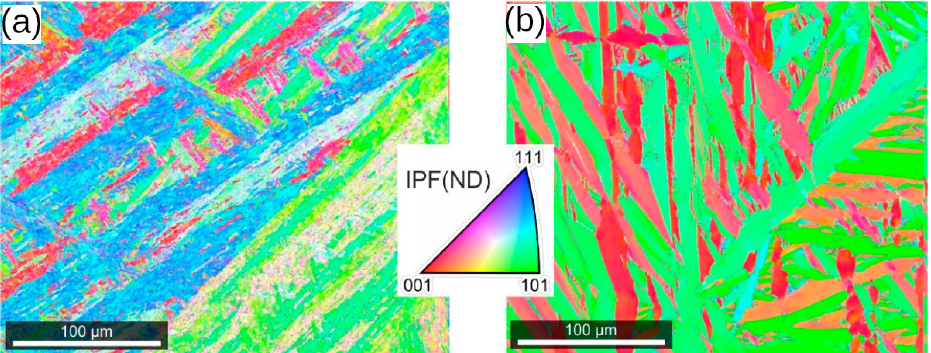
Figure 6. Orientation imaging SEM inverse pole figures for two types of martensitic microstructures: lath and plate are illustrated. Picture ( a ) shows a typical lath type microstructure of martensite in Fe–25Ni where as picture ( b ) reveals the plate martensite in Fe–30Ni alloy